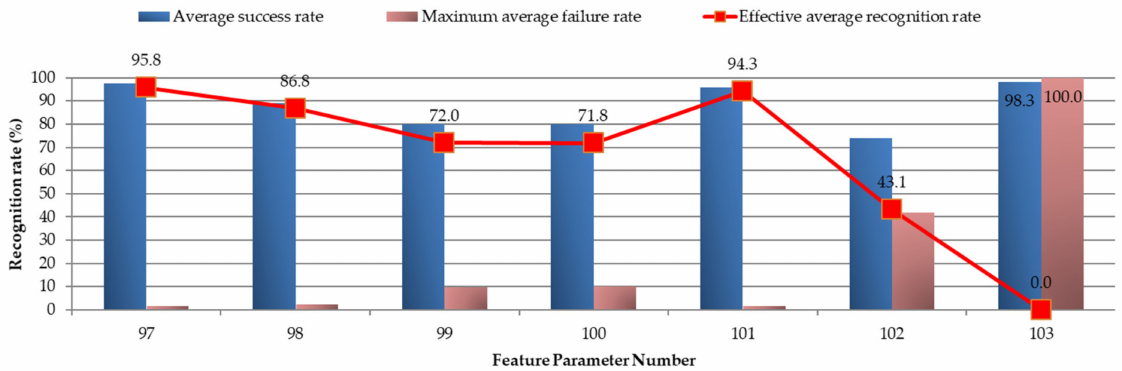
Figure 35. GIS-2 partial discharge characteristic parameter: discharge intensity distribution recogni- tion